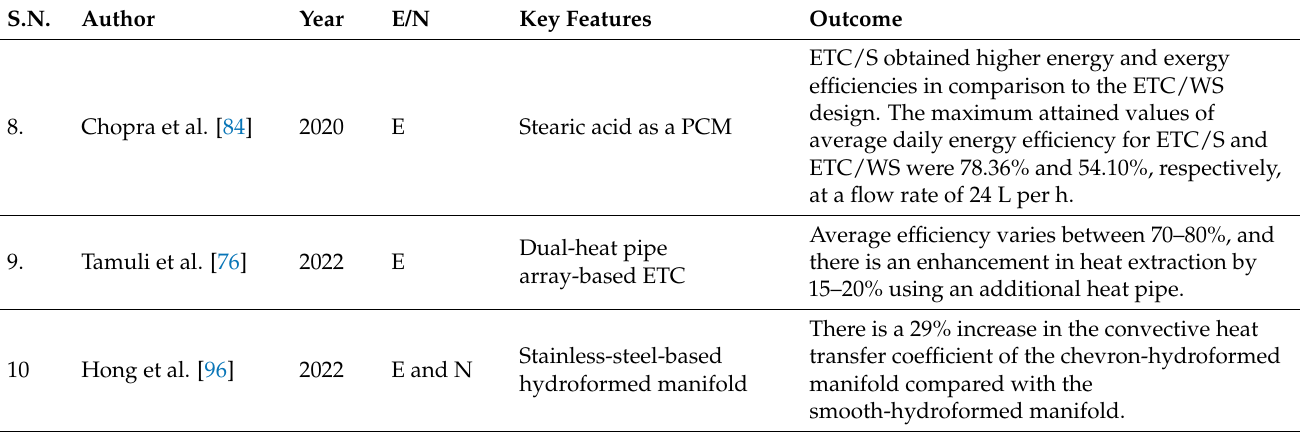
Table 3. Summary of investigation on heat pipe ETC-PCM/nanofluid-based